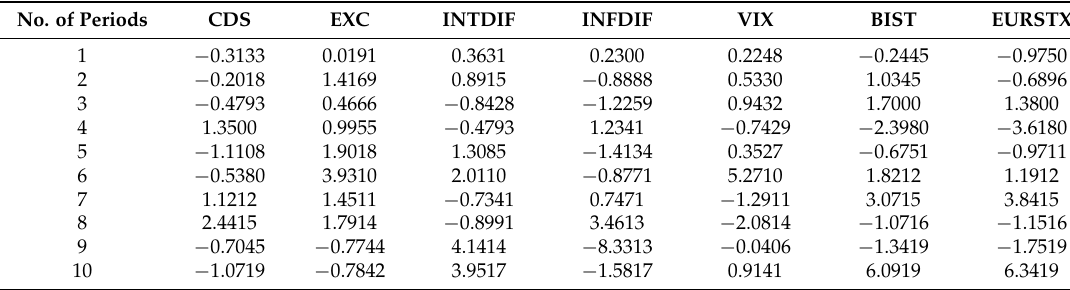
Table 9. Response of EXC to 1% positive shock for other variables in regime